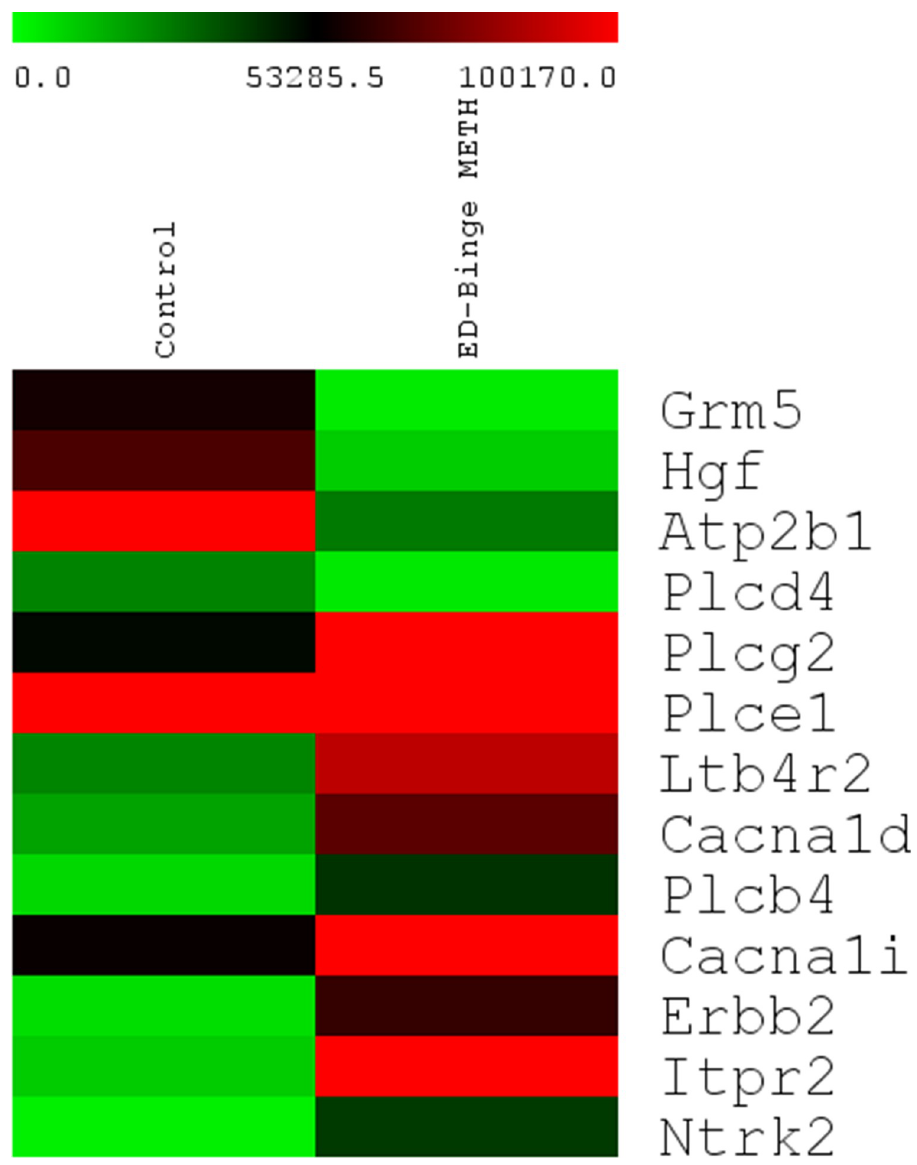
Fig 1. A heat map representing differentially expressed proteins of the calcium signalling pathway in rat testis (METH vs. control). Bright green, dark green, and bright red colours represent the absence, lowest, and highest protein expression,